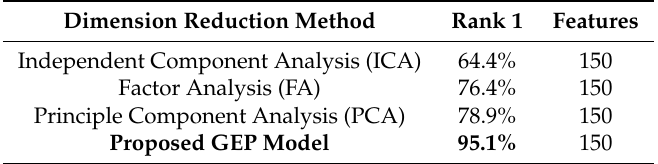
Table 7. Comparison of different dimensionality reduction techniques and the proposed GEP